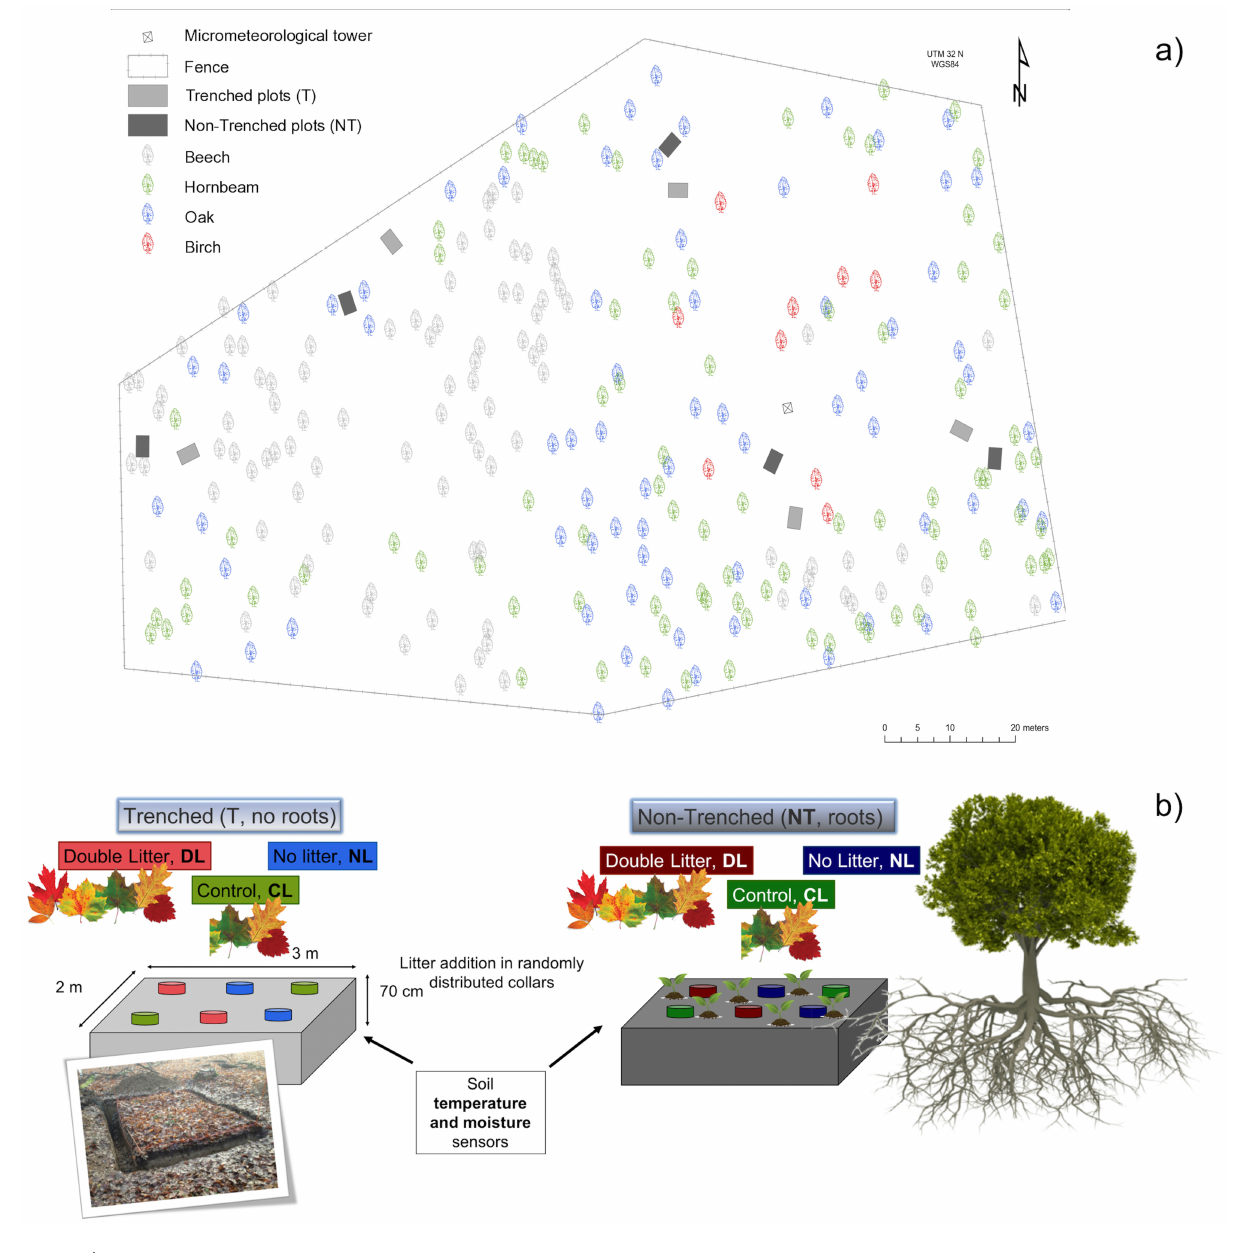
FIGURE 1 | (a) Location of the paired Trenched and Non-Trenched plots in the study area. (b) Scheme of the experimental design showing the distribution of the trenching and leaf litter input treatments within each